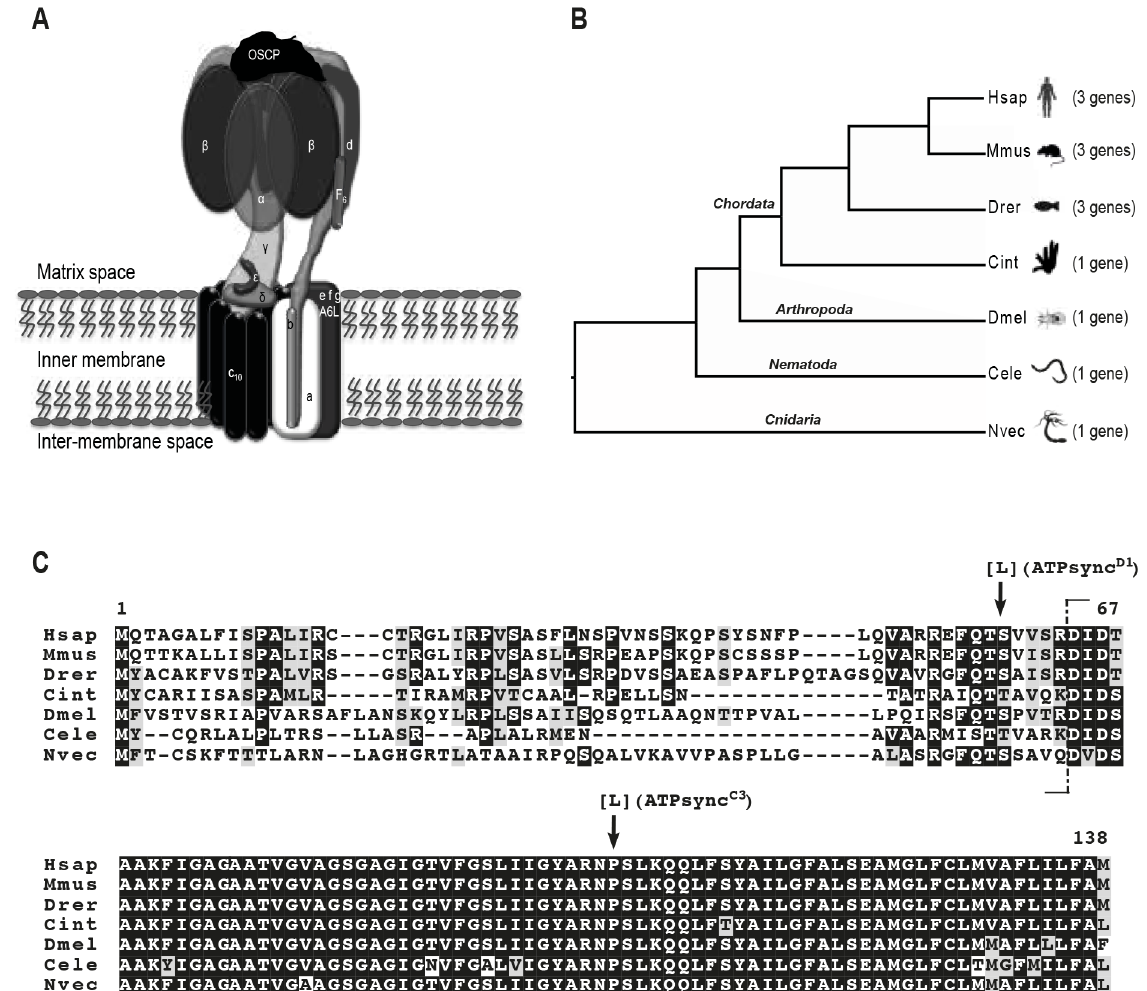
Fig 1. The mitochondrial ATP synthase and its subunit c. (A) Structural organization of the mature mitochondrial ATP synthase. (B-C) Number of genes and protein alignment of the mitochondrial ATP synthase subunits c from representative metazoan species (see text for details). Hsap = Homo sapiens ; Mmus = Mus musculus ;Drer = Danio rerio ; Cint = Ciona intestinalis ; Dmel = Drosophila melanogaster ; Cele = Caenorhabditis elegans ; Nvec = Nematostella vectensis .(C) The dashed vertical line separates the N-terminal mitochondrial targeting peptide from the mature subunit c; arrows point to amino acid substitutions, due to EMS-induced mutations, in the coding sequence of ATPsynC C3 and ATPsynC D1 alleles.